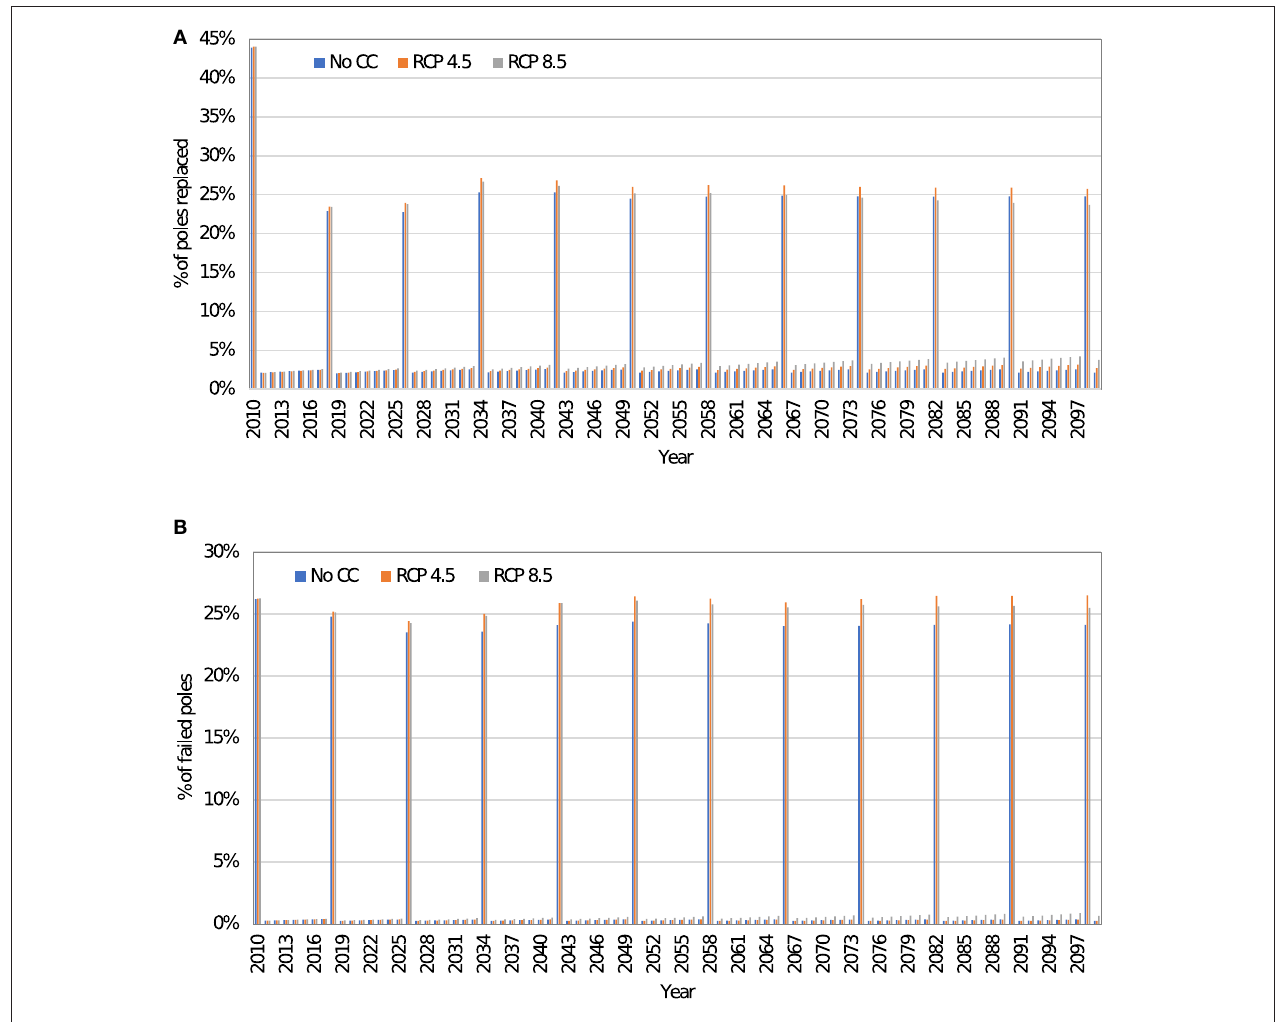
FIGURE 8 | Percentage of poles replaced (8-year inspection cycle) (A) Miami (B) NYC.